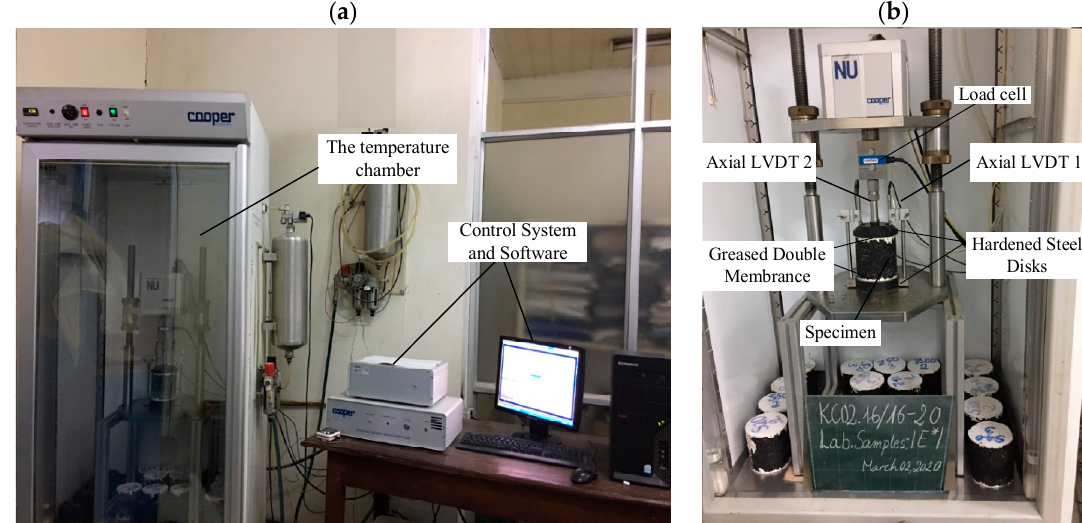
Figure 3. Dynamic Modulus testing: ( a ) The temperature cabinet and control system, ( b ) General Schematic of Dynamic Modulus Test.